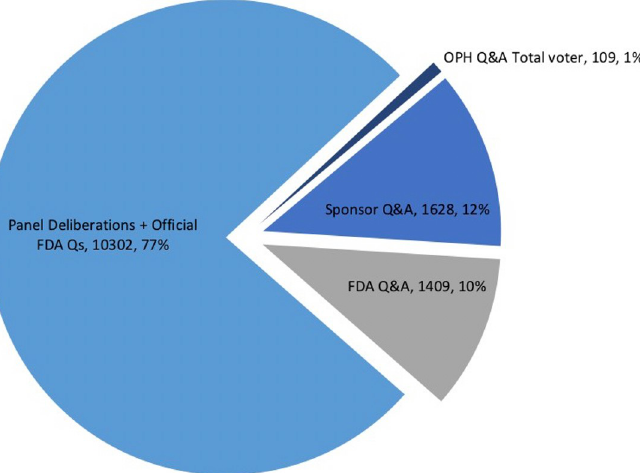
Fig 1. Average number of words spoken by all voting members during major meeting segments, per meeting.